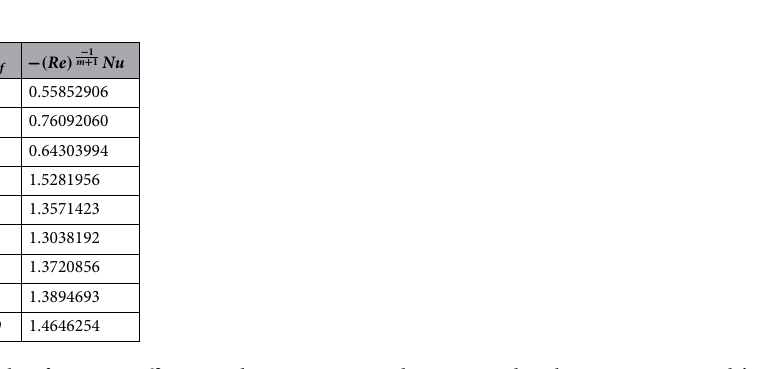
Table 4. Variation in skin friction coefficient and temperature gradient versus distribution in H t , F r and (cid:31) including tri-hybrid